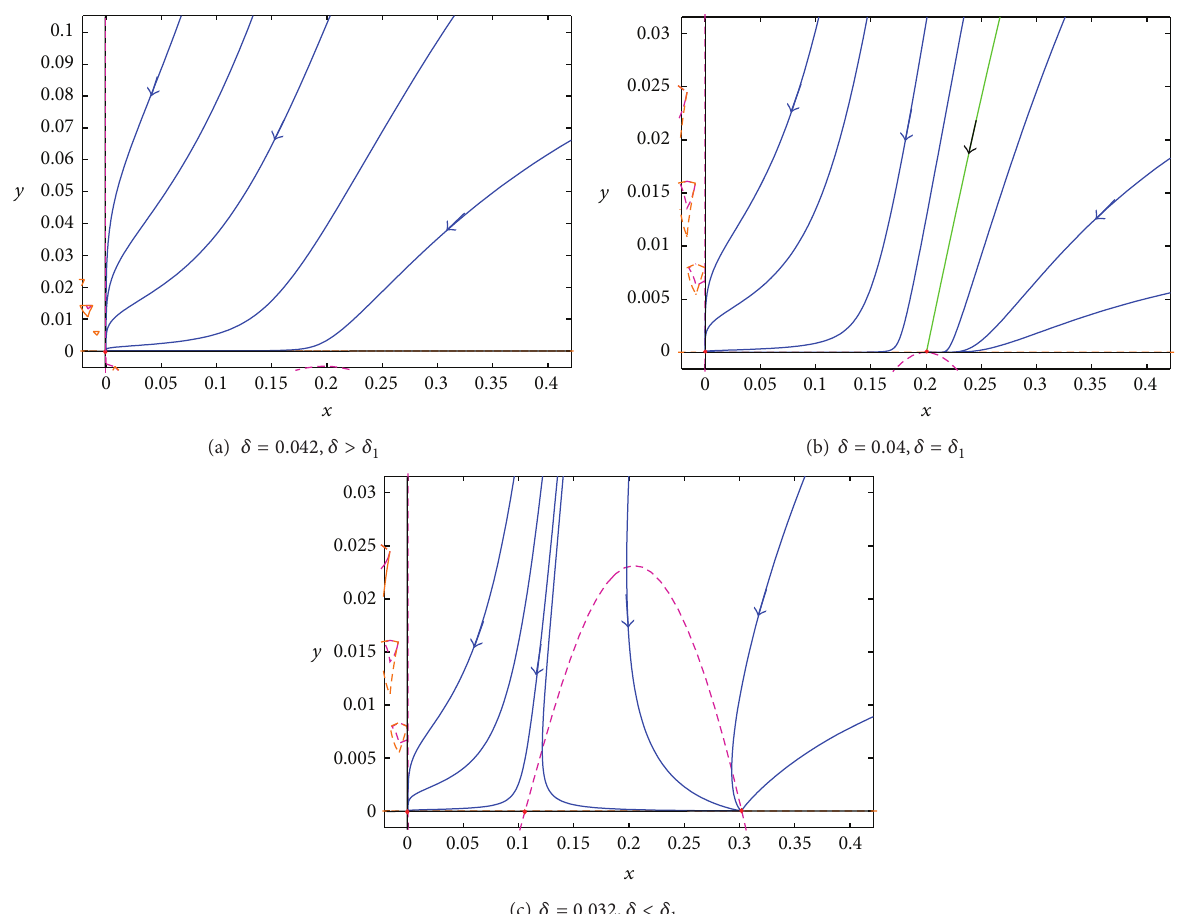
Figure 1: Phase portraits of system (7) if 𝛼 1 < 𝛽 and for 𝑔 = 1.44 , 𝛿 1 = 0.04 , 𝛼 = 0.4 , 𝛼 1 = 0.1 , and 𝛽 = 0.3